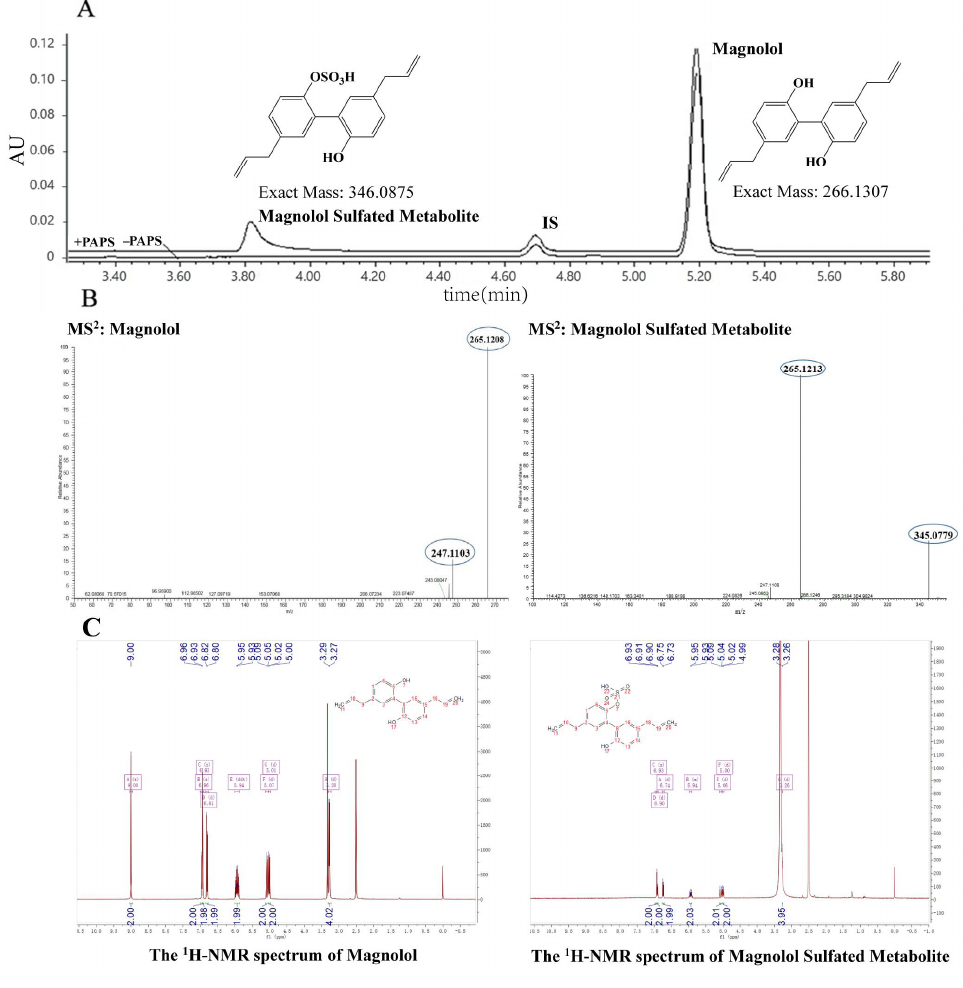
Figure 1. ( A ) Representative ultraperformance liquid chromatography chromatogram for the quantitative analyses of magnolol and its sulfated metabolite in HLS9. ( B ) Representative MS/MS (MS 2 ) spectra of magnolol and its sulfated metabolite. ( C ) Representative 1 H-NMR spectra of magnolol and its sulfated metabolite. Table 1. 1 H-NMR chemical shifts ( δ ) of magnolol and magnolol sulfated